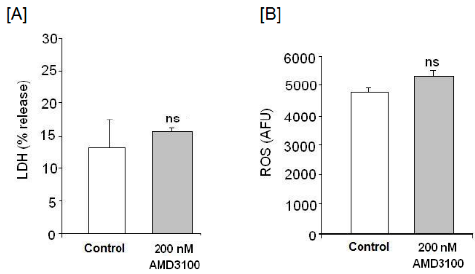
Figure 2. Effect of AMD3100 on ( A ) lactate dehydrogenase (LDH) release; and ( B ) reactive oxygen species (ROS) generation. Results are expressed as means ± SEM of two experiments from different cultures, each one performed by triplicate with different batches of cells. The statistical significance was evaluated by t -Student test using Sigma Plot 11 software. Differences were considered significant at p < 0.05, statistical significance as compared to control. ns = no significant